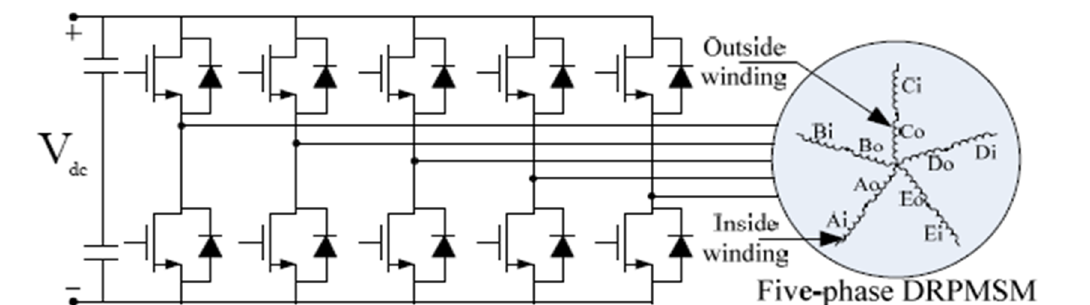
Figure 23. No-load Back EMF in ( a ) inner motor; and ( b ) outer motor.